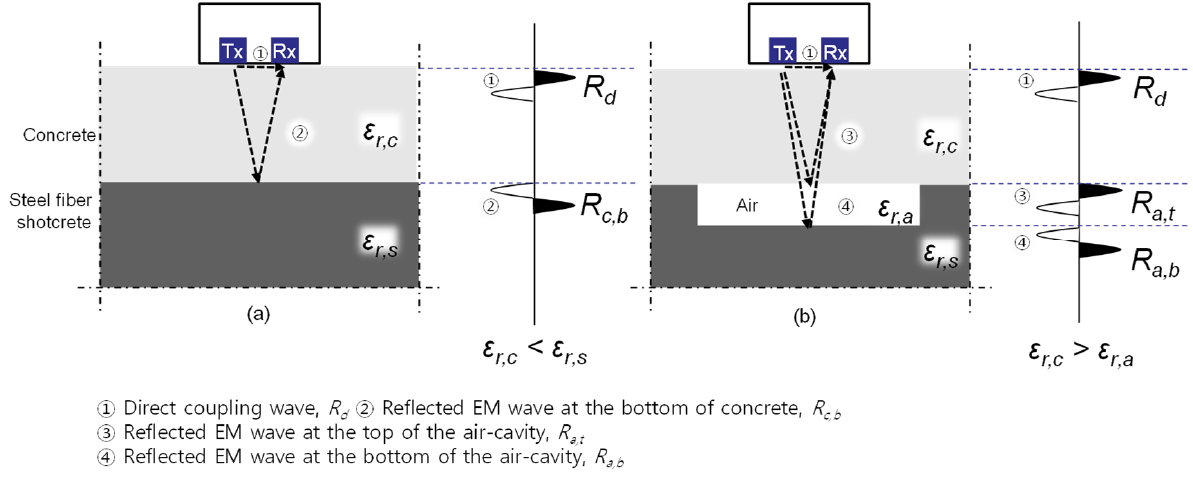
Figure 5. Typical paths of electromagnetic waves propagating: ( a ) in the solid tunnel structure without air-cavity, and ( b ) in the defected tunnel structure with air-cavity behind concrete.